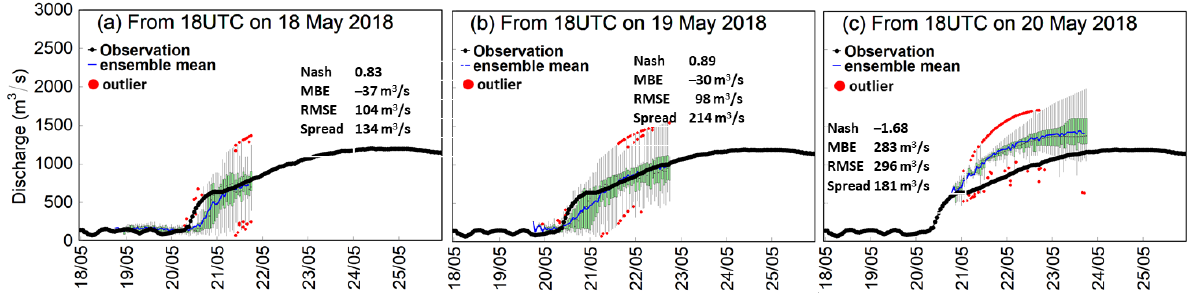
Figure 15. Same as Figure 14 but for each forecasting time starting from 18 UTC on ( a ) 18 May, ( b ) 19 May, and ( c ) 20 May 2018.